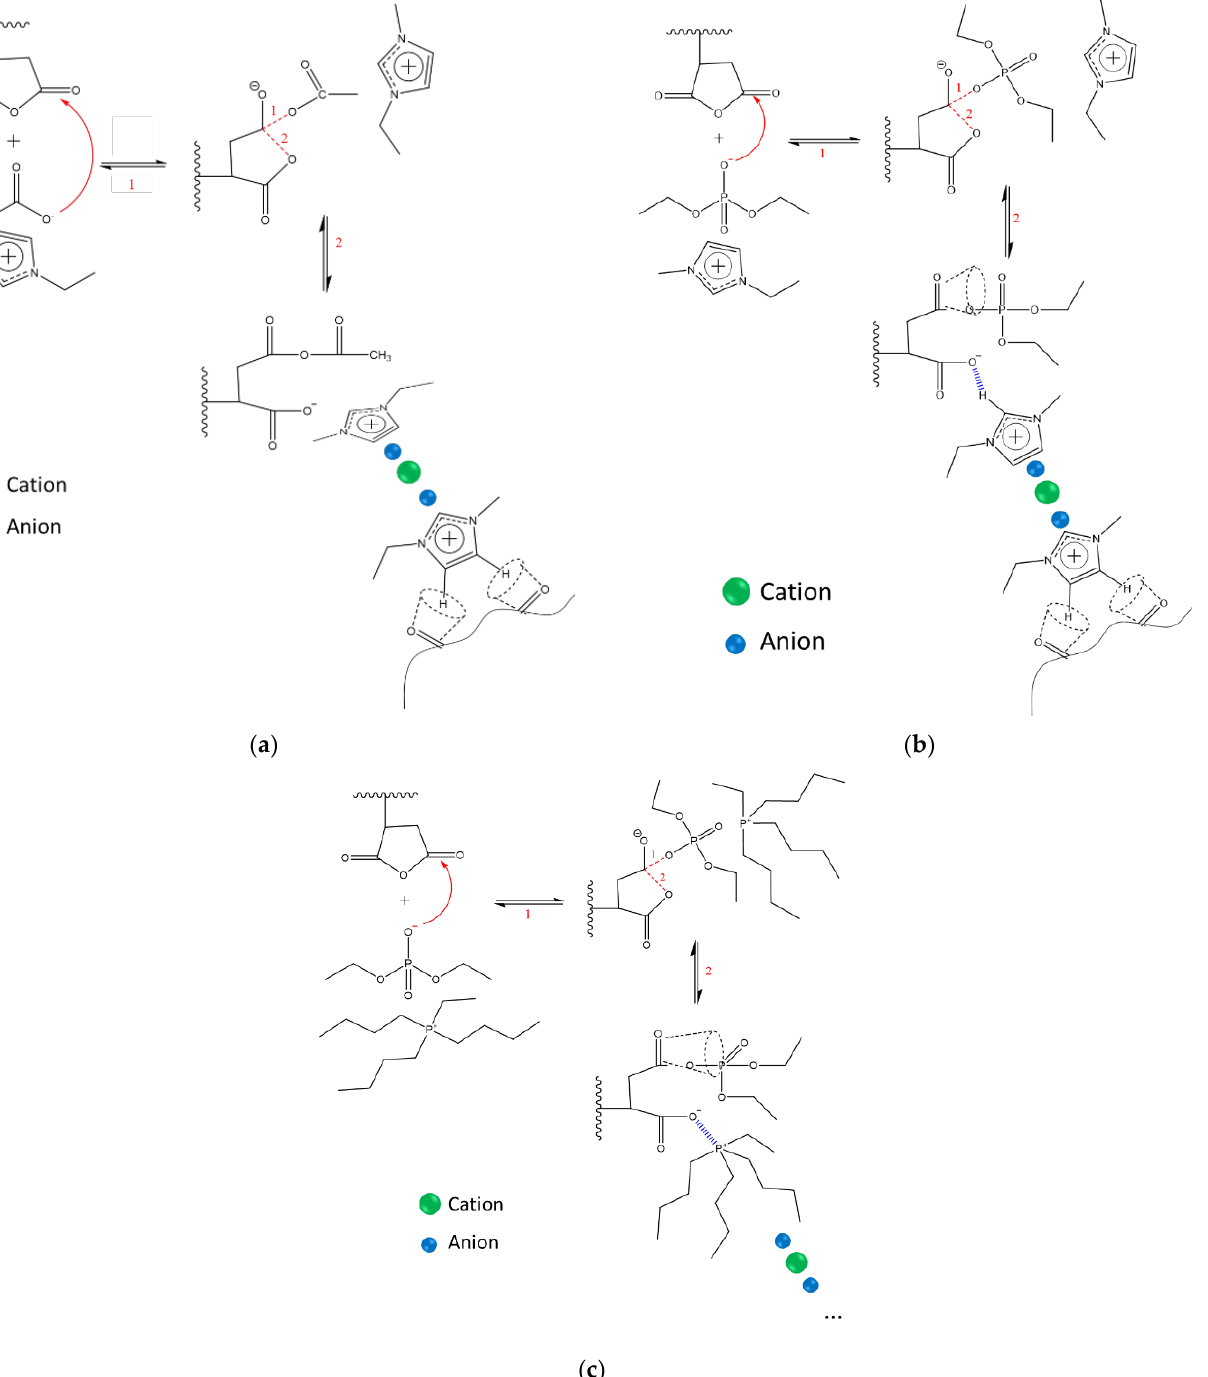
Figure 5. The various types of interactions which could be established between ionic liquid pairs and PPgMA within the different LIonomers materials considered in this study (based on: EMIM Ac: ( a ); EMIM DEP: ( b ); P + DEP: ( c ). ( a ); EMIM DEP: ( b ); P + DEP: ( c